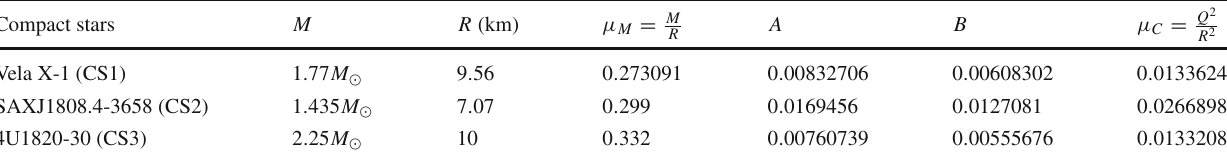
Table 1 The approximate values of the masses, radii and compactness for charged compact stars, Vela X-1, SAXJ 1808.4-3658, and 4U 1820-30 and their numerical values of the constants A , and B Compact stars